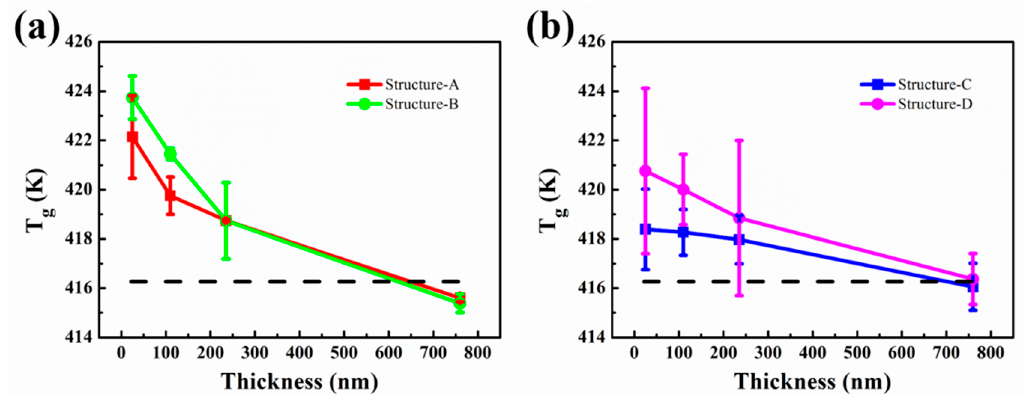
Figure 6. The spatial T g s of different thickness of TC1-labeled PMMA film for ( a ) structure-A/B and ( b ) structure-C/D: the T g s of each film in the plot are defined by its average temperature, and the black dash line indicates the T g of the bulk TC1-labeled PMMA film supported on the quartz substrate.